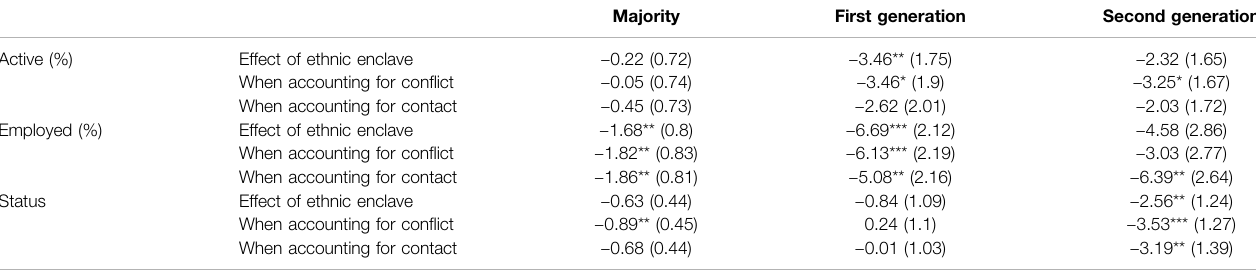
TABLE 3 | Con fl ict and contact mediating the relationship between ethnic enclaves and labor market outcomes.